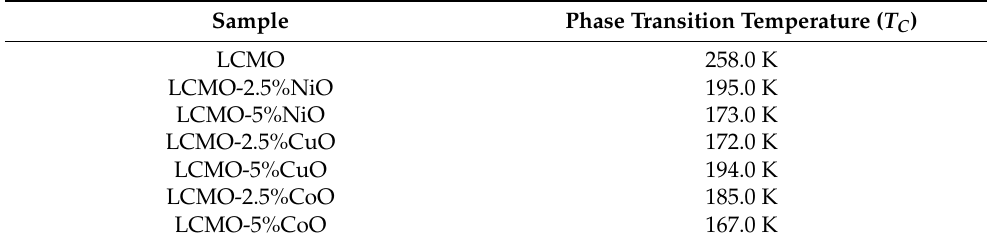
Table 3. The magnetic phase transition temperature of LCMO–MO composite